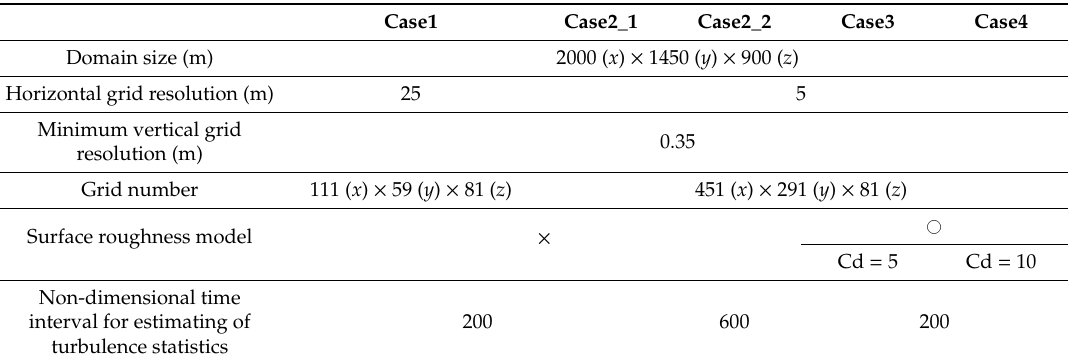
Table 1. Simulation cases studied in the present